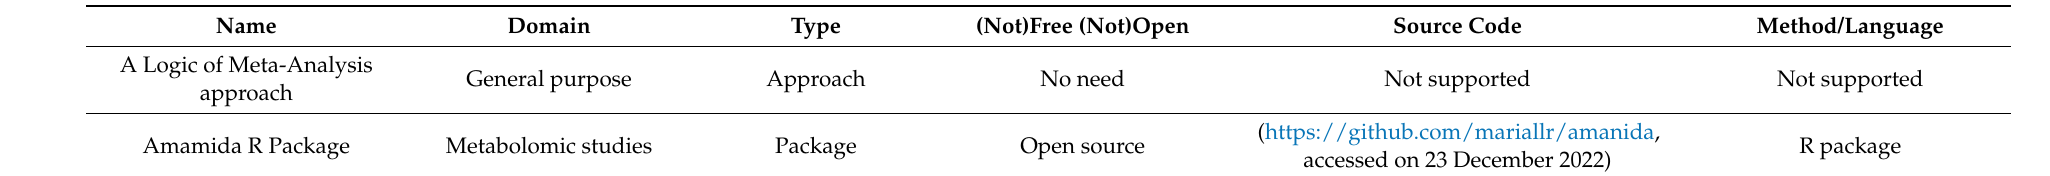
Table 2. The characteristics of the studies’